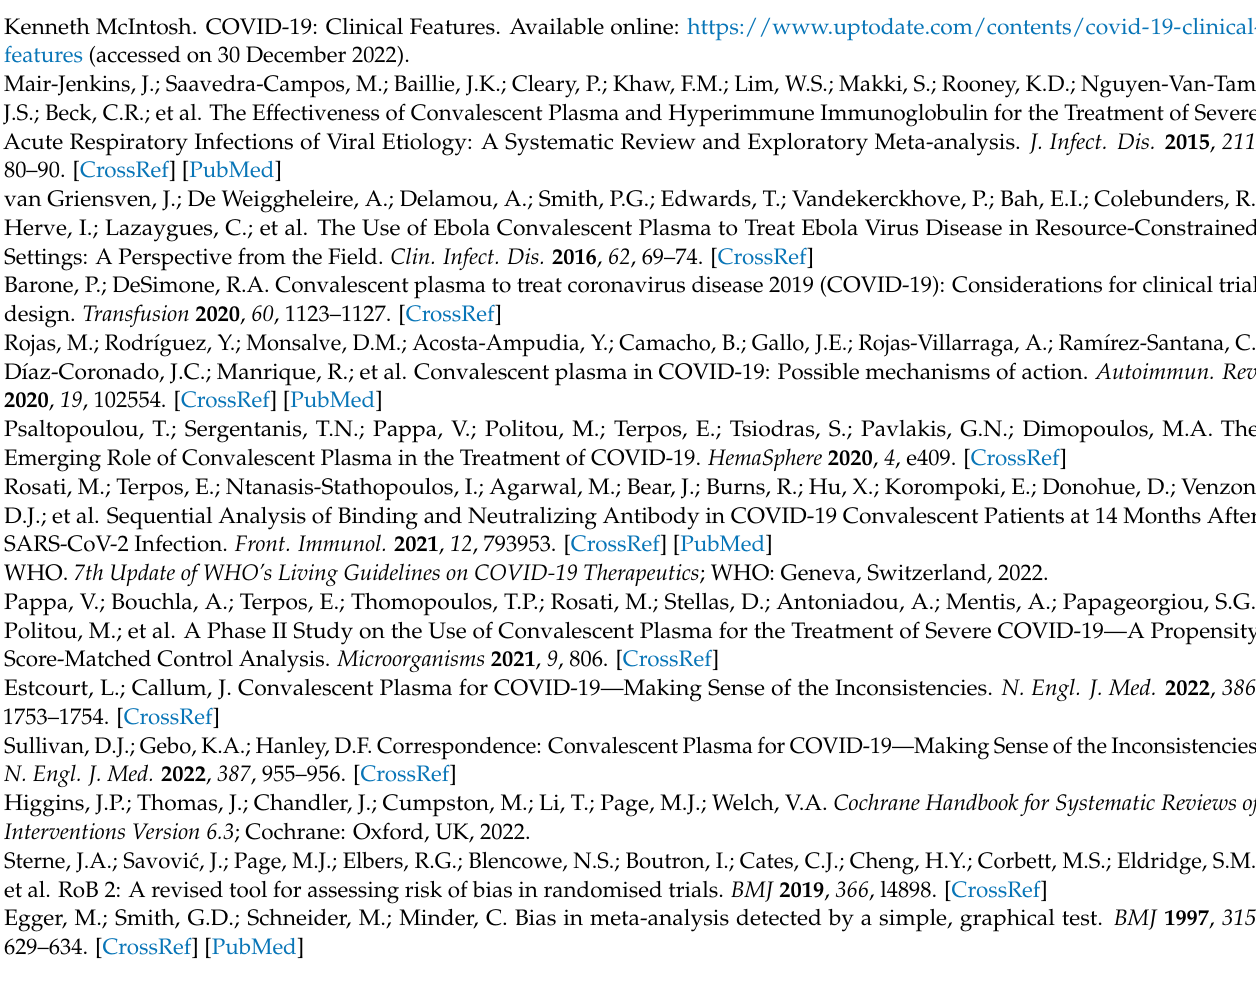
by multicenter status; Figure S24. 28-day score-related outcomes, by blinding status; Figure S25. 28-day score-related outcomes, by geographic region; Figure S26. 28-day score-related outcomes, by titer; Figure S27. 14-day mortality, by adjustment; Figure S28. 14-day mortality, by multicenter status; Figure S29. 14-day mortality, by blinding status; Figure S30. 14-day mortality, by geographic region; Figure S31. 14-day mortality, by titer; Figure S32. 14-day hospital discharge, by adjustment; Figure S33. 14-day hospital discharge, by multicenter status; Figure S34. 14-day hospital discharge, by blinding status; Figure S35. 14-day hospital discharge, by multicenter status; Figure S36. 14-day hospital discharge, by titer; Figure S37. Funnel plot, portraying publication bias for 28-day mortality; Figure S38. Funnel plot, portraying publication bias for 28-day ICU-related